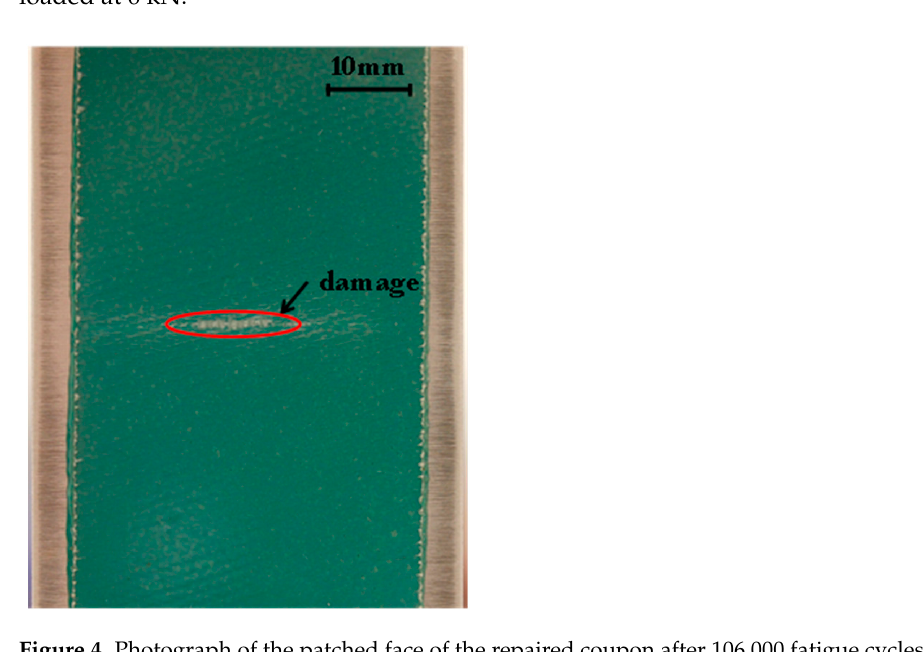
Figure 4. Photograph of the patched face of the repaired coupon after 106,000 fatigue cycles.